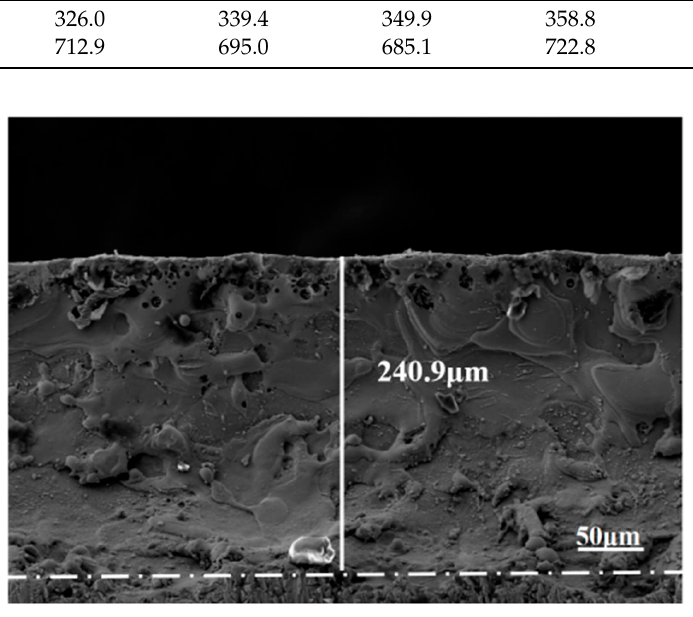
Figure 8. Cross-sectional view of nitriding sample.